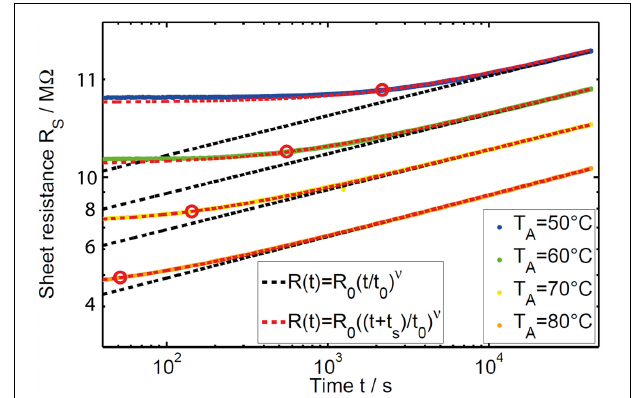
FIGURE 4 | Resistance drift measured in GeTe thin films at annealing temperatures between 50 and 80 ◦ C plotted on double logarithmic scale. The dashed lines indicate the fits by the commonly used simple power law (black) and the extended power law (red) to the experimental data (solid lines) at different annealing temperatures. The simple power law was only fitted to data for times much greater than the individual virtual age of the sample (red